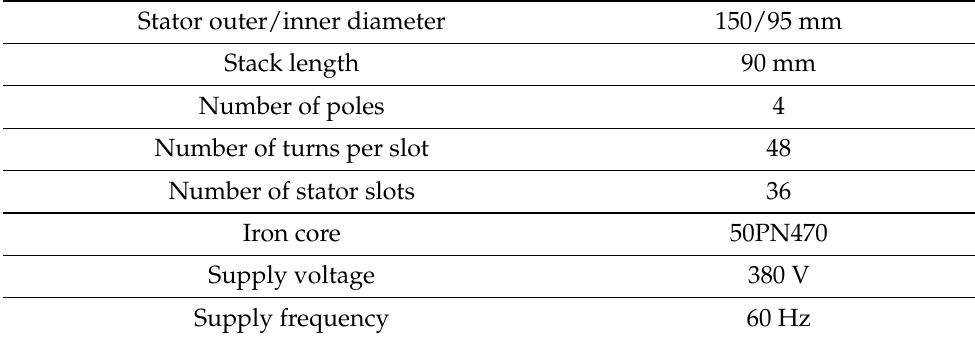
Table 2. Key motor data of the 1.5 kW LS-SynRM.